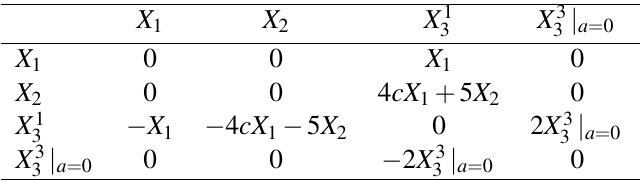
Table 8: Adjoint table for the Lie algebra { X